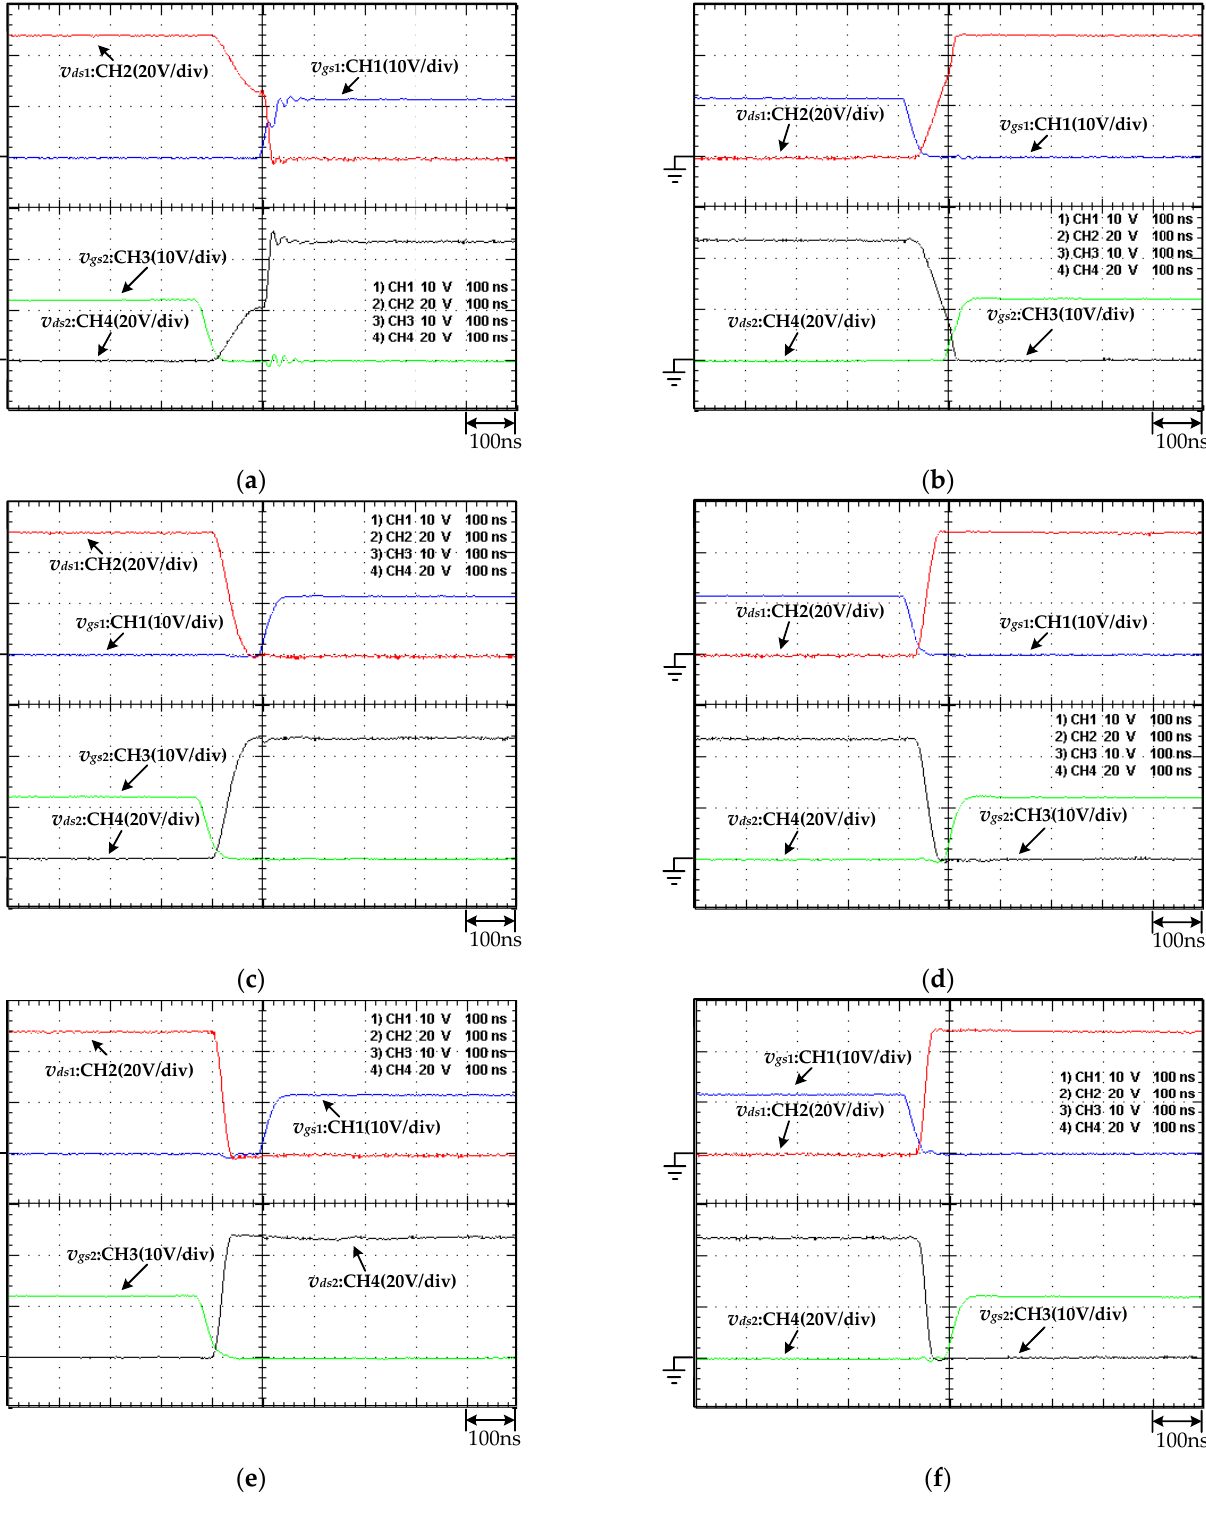
Figure 10. Measured waveforms of v gs 1 , v ds 1 , v gs 2 , and v ds 2 at input 48 V under ( a ) Q 1 turned-on at 10% load; ( b ) Q 1 turned-off at 10% load; ( c ) Q 1 turned-on at half load; ( d ) Q 1 turned-off at half load; ( e ) Q 1 turned-on at full load; and ( f ) Q 1 turned-off at full load.